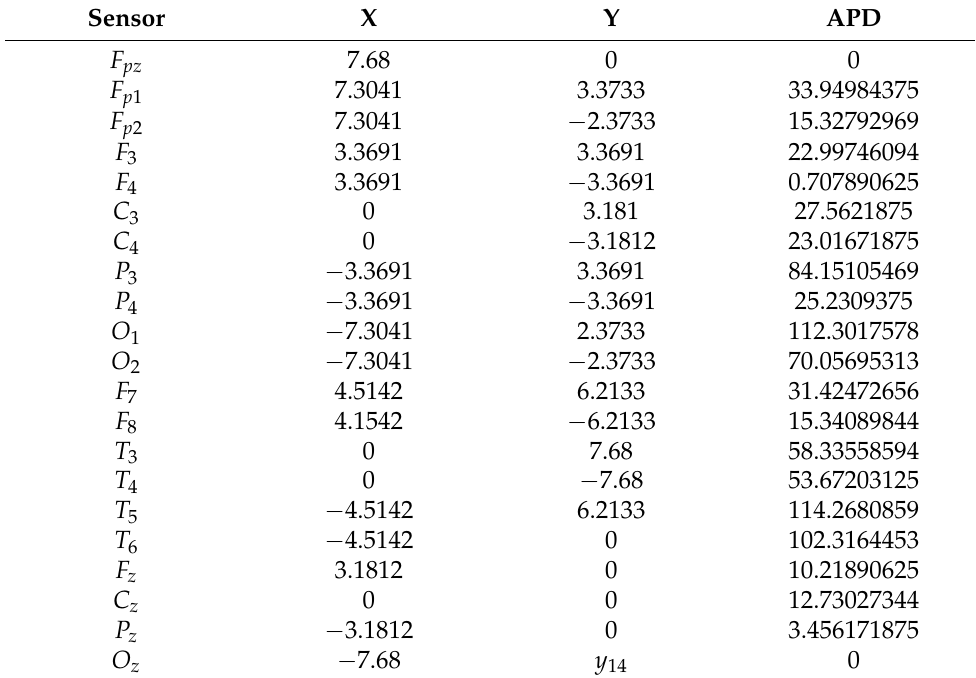
Table 3. APD at the sensor on an MC at t = 2 of patient A [14].